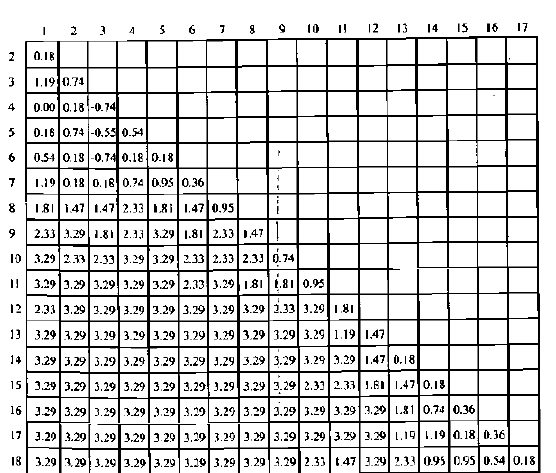
FIGURE 2. Pitch discrimination matrix for subject JEM for BP+3 stimulation mode. Note that the number of available electrodes was only 18 instead of 20. That is because the return electrode, for elec- trode 18 as stimulation electrode in BP+3 mode, is electrode band 22, which is the most basal electrode band. Also, note that the pitch discrimination pat- tern differs from that in figure 1. Some electrodes which did not exhibit good discrimination in BP+1 mode, had good discrimination in BP+3 mode. Com- pare the d' between electrodes 11 and 12 in these stimulation modes. The inverse was also true for some electrodes.